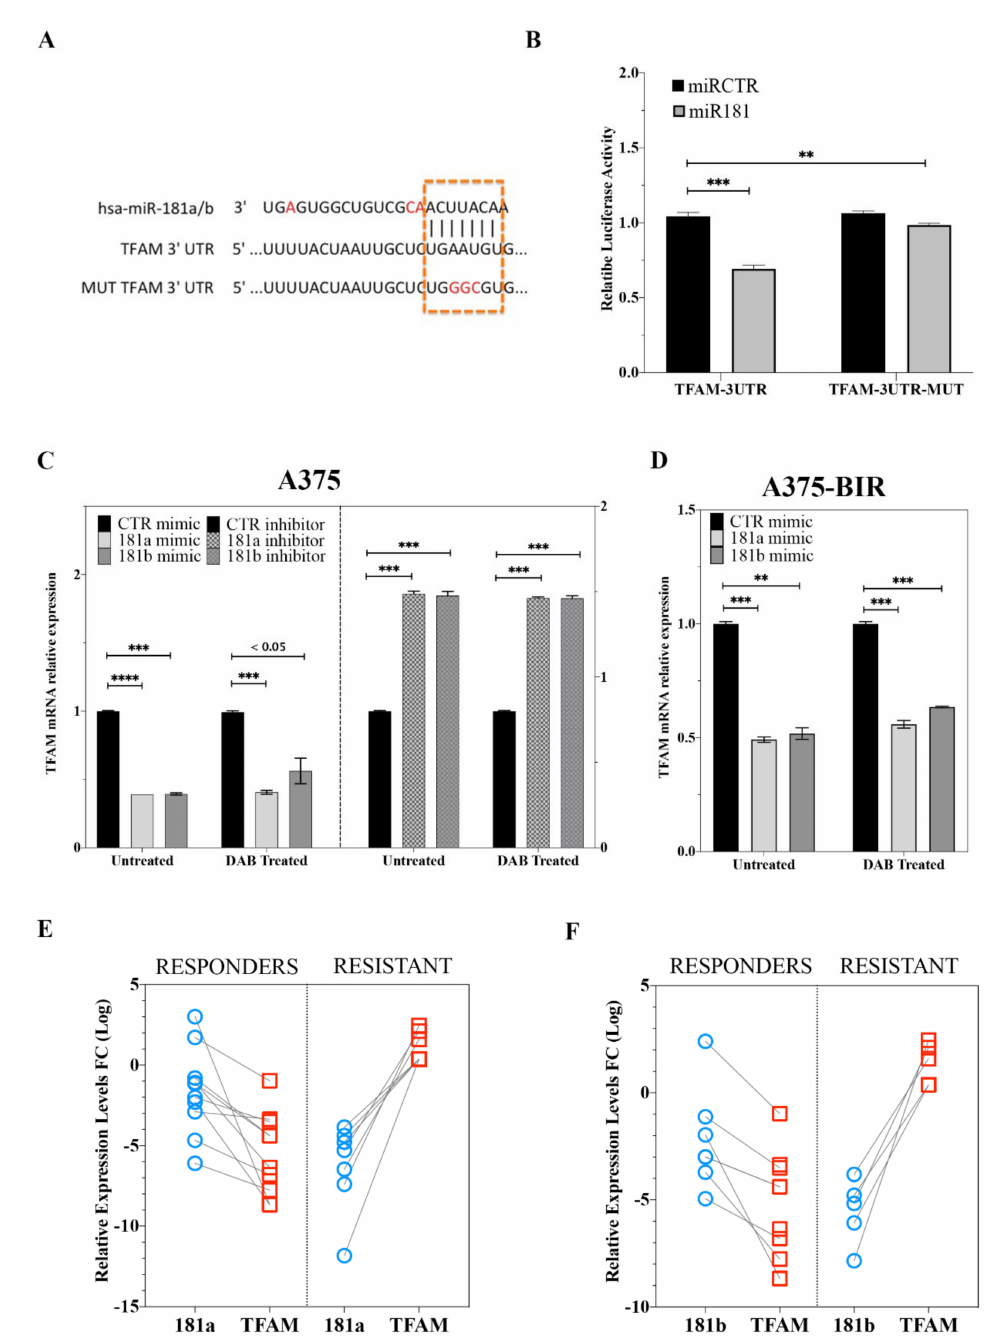
Figure 6. ( A ) TFAM 3 (cid:48) UTR contains miR-181a and -181b binding sites. Red-labelled nucleotide indicate the differences between the sequences of miR-181a and -181b. ( B ) The dual luciferase reporter assay was performed with HeLa cells as described in Materials and Methods. Briefly, HeLa cells were transfected with miR-181a or miR mimic negative control together with the plasmid encoding for the Firefly luciferase (FFL) carrying part of the TFAM 3 (cid:48) -UTR in its wild type form (TFAM-3UTR) or TFAM 3 (cid:48) -UTR with the mutagenized form of the miR-181a and -181b binding site (TFAM-3UTR-MUT). FFL activities were internally normalized to Renilla luciferase activities yielding relative light units (RLU). Histograms show the mean +/ − SE from 3 to 6 independent experiments upon normalization to the miR mimic control. ** p < 0.01; *** p < 0.001 in un-paired t-test. ( C , D ) TFAM mRNA expression analysis in A375 ( C ) and A375-BIR ( D ) cells transfected with miR-181a, -181b mimics or their inhibitors or relative controls. Histograms show the mean +/ − SE from 3 independent experiments upon normalization to the miR mimic control. ** p < 0.01; *** p < 0.001; **** p < 0.0001 in un-paired t-test. ( E , F ) Treatment resistant and responder melanomas display miR-181a/b/ TFAM axis deregulation. Lower miR-181a ( E ) and -181b ( F ) and higher TFAM expression levels in patients resistant during therapy compared to tumors from the responder group. p < 0.001 by Mann-Whitney U